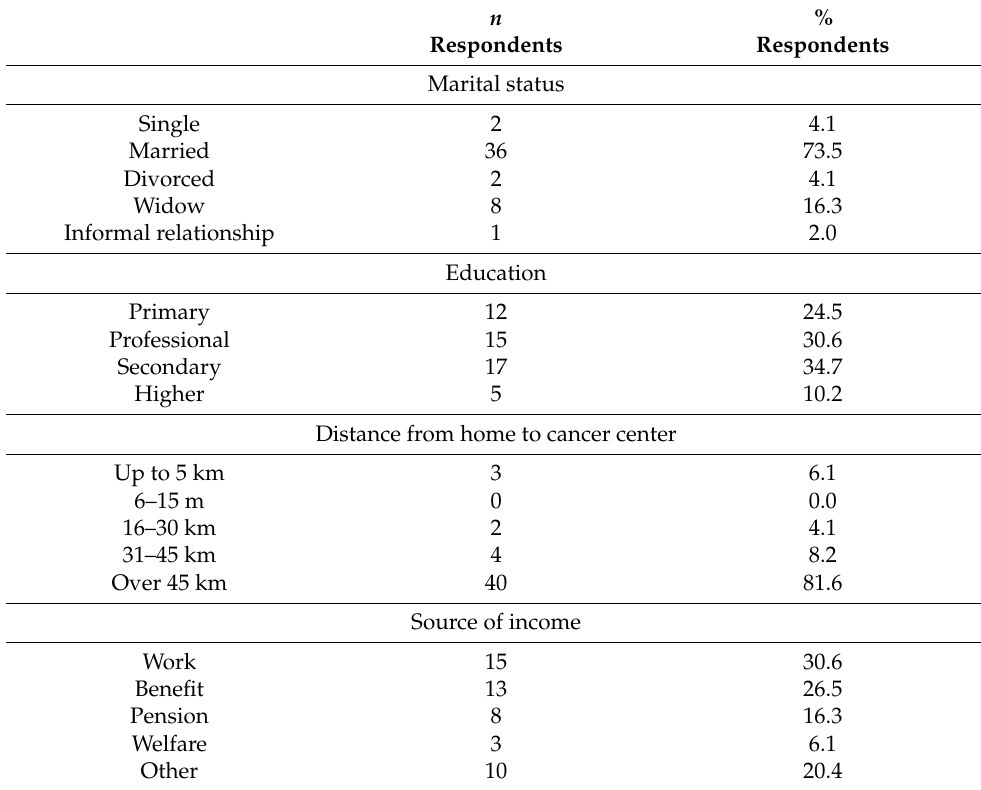
Table 1. Socio-demographic characteristic of the study